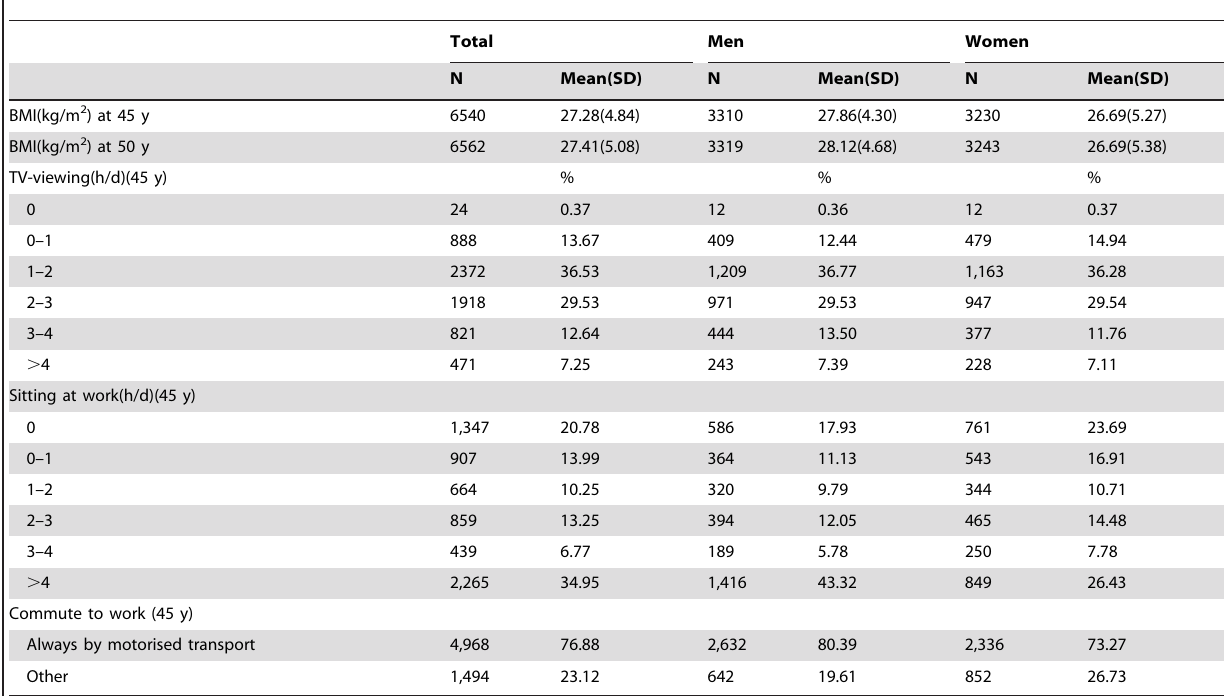
Table 1. Mean (SD) Body mass index (BMI) at 45 y and 50 y and 45 y Sedentary Behaviour (N, %) for Participants in the Study (N=